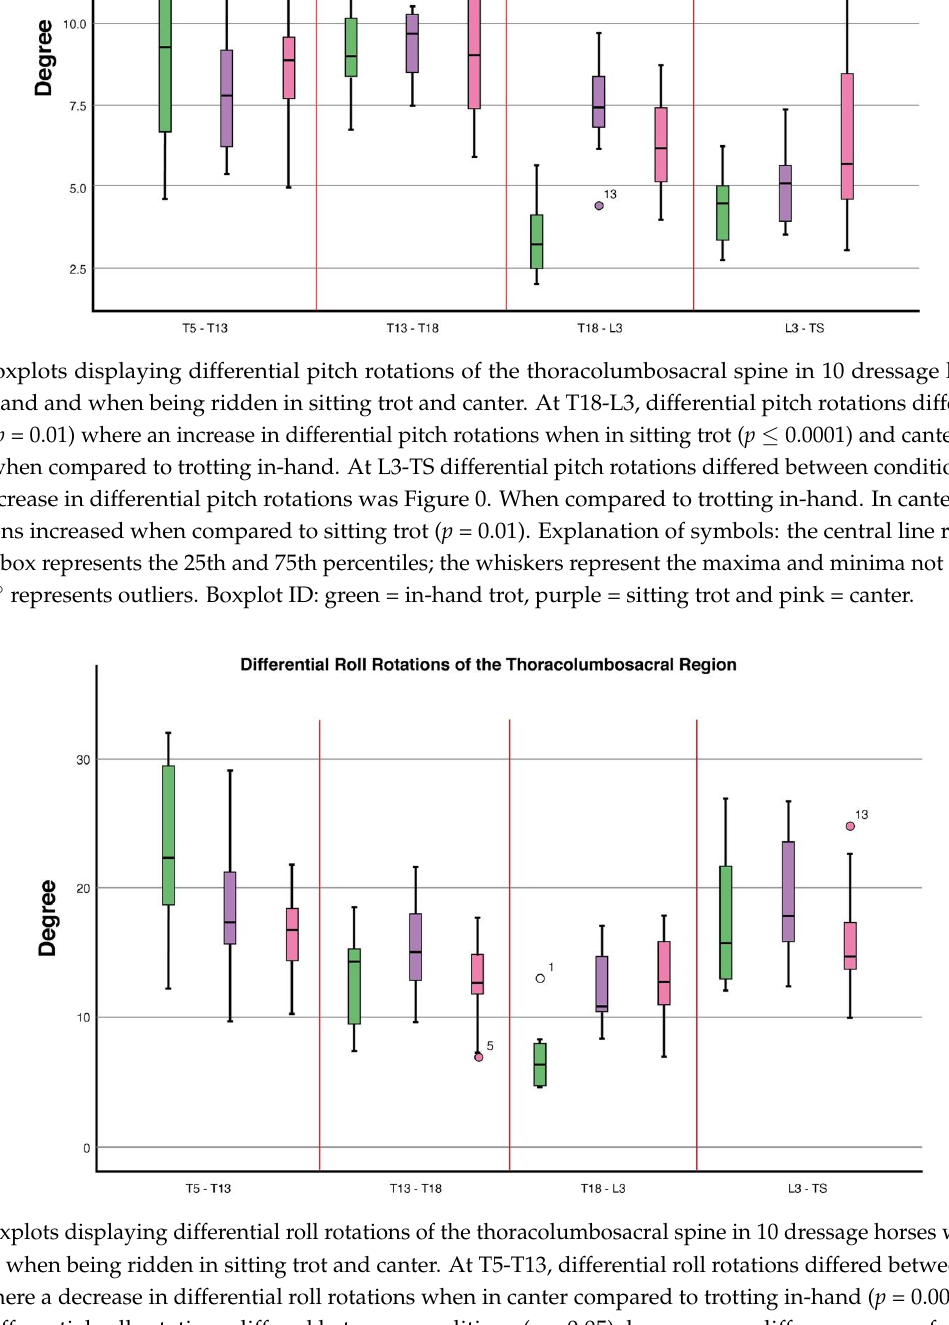
Figure 6. Boxplots displaying differential heading rotations of the thoracolumbosacral spine in 10 dressage horses whilst trotting in-hand and when being ridden in sitting trot and canter. At T5-T13, differential heading rotations differed be- tween conditions ( p ≤ 0.0001) where a decrease in sitting trot ( p ≤ 0.0001) and canter ( p = 0.0001) when compared to trotting in-hand was found. At T18-L3 differential heading rotations differed between conditions ( p ≤ 0.0001) where an increase in